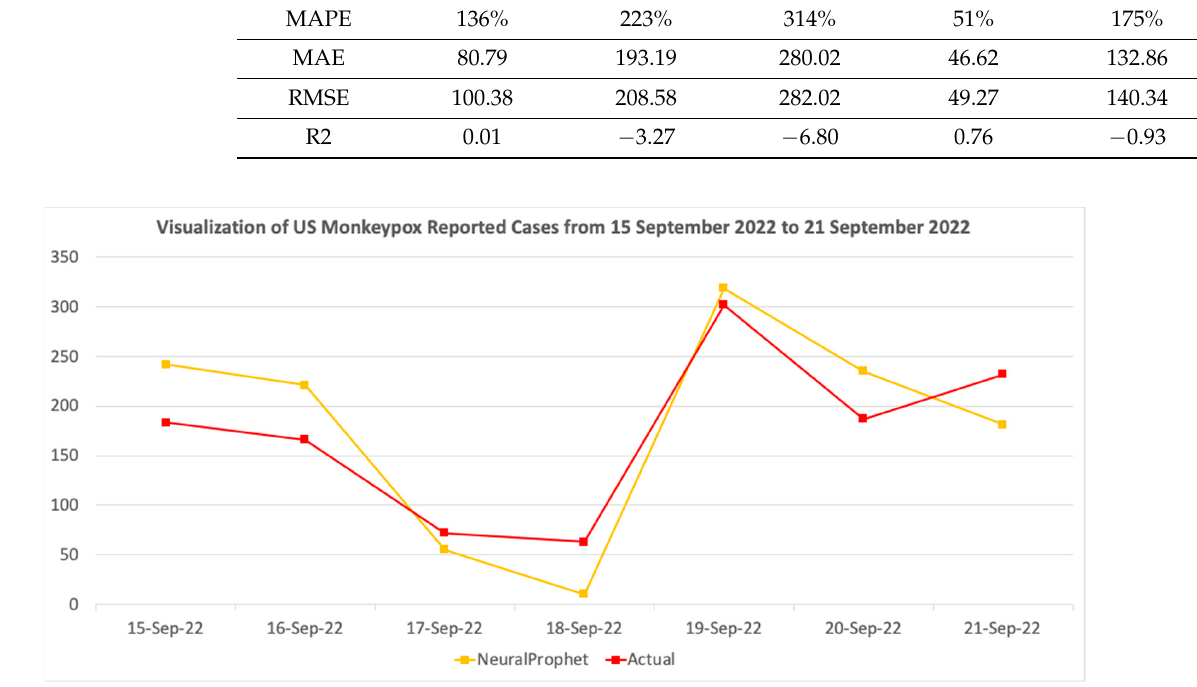
Figure 7. Forecast using NeuralProphet for the next 7 days from 15 September 2022 to 21 September 2022.